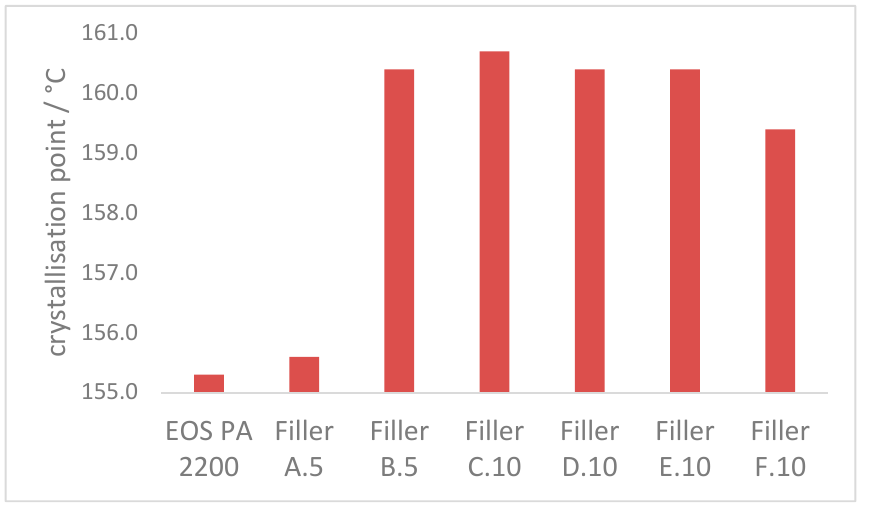
Figure 9. Crystallization properties–crystallization point comparison at 5 K min − 1 .